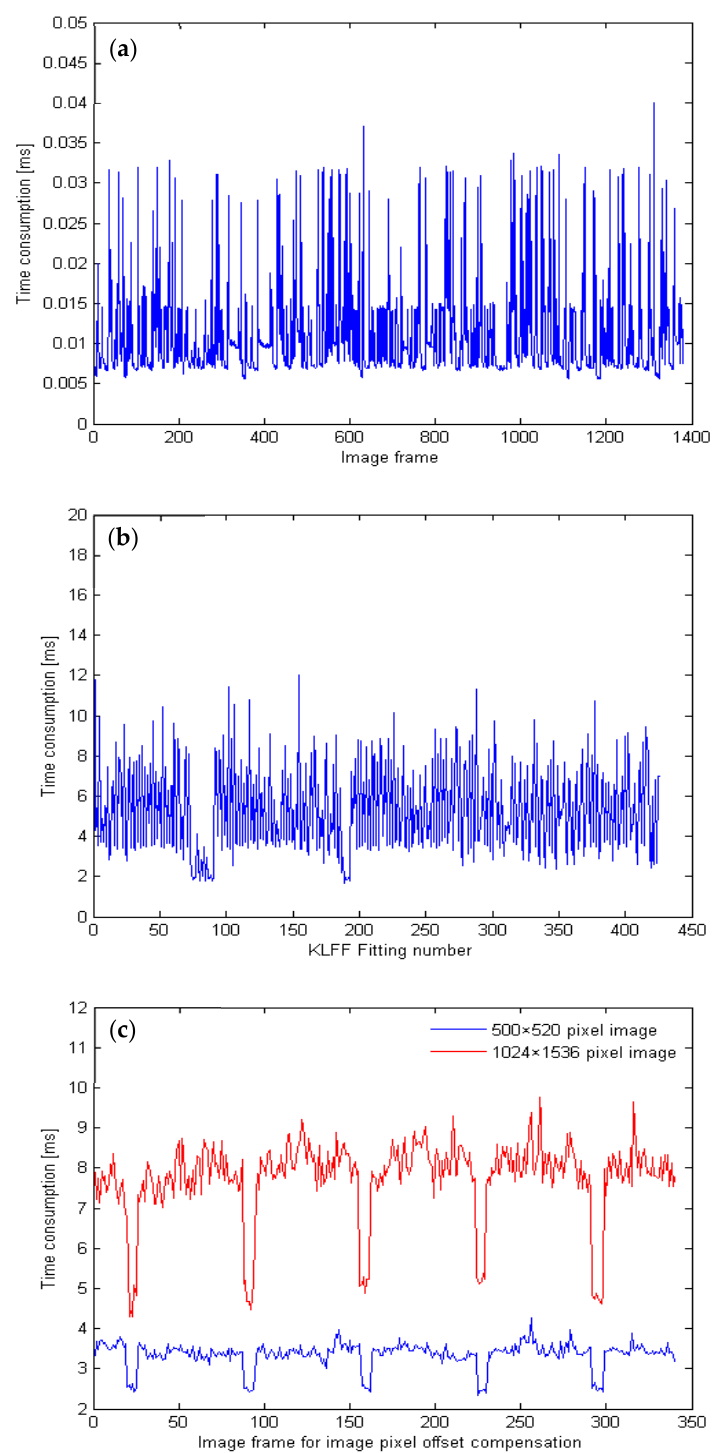
Figure 18. Algorithm time consumption: ( a ) time consumption of each frame of image pixel offset calculation; ( b ) time consumption situation of each KLFF algorithm fitting; ( c ) time consumption situation of image pixel offset compensation for each frame under different windowing modes.